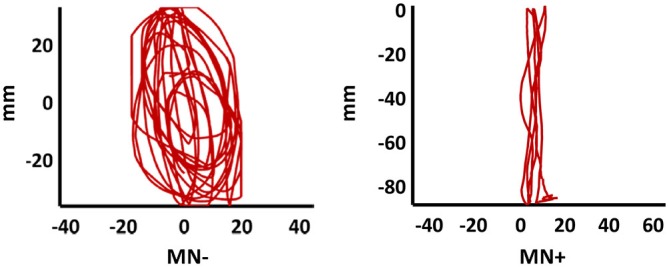
Patients’ drawing in CL condition. Examples of patients’ right hand trajectory in bimanual CL condition. Note the evident ovalization for MN− but not for MN+.